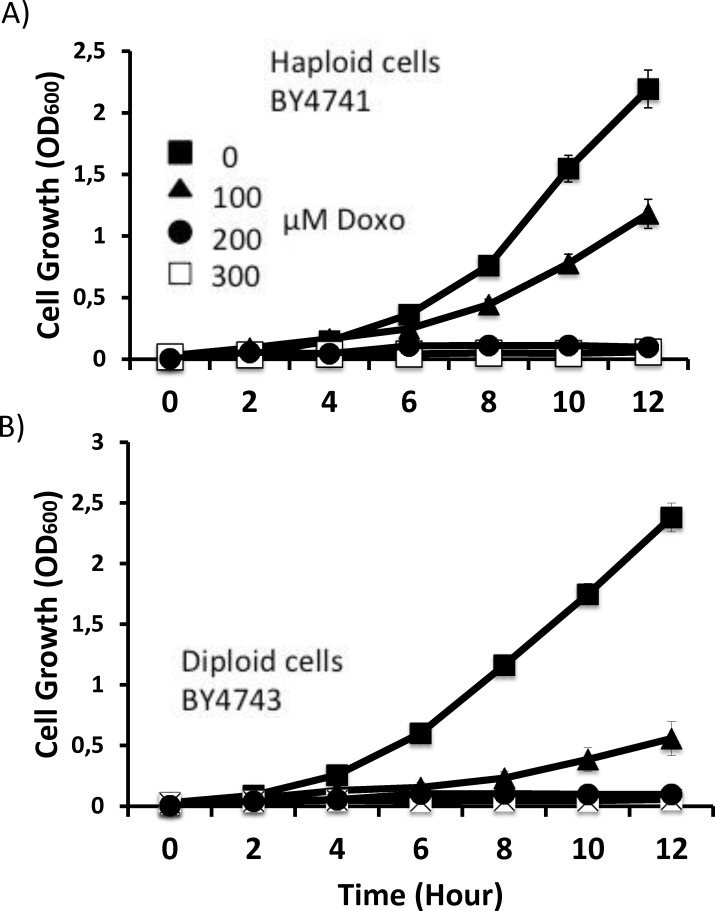
Growth curves.Wild type (A) haploid and (B) diploid yeast strains on 0 μM, 100 μM, 200 μM and 300 μM doxorubicin media. Error bars represent SD of the means for triplicate determinations.